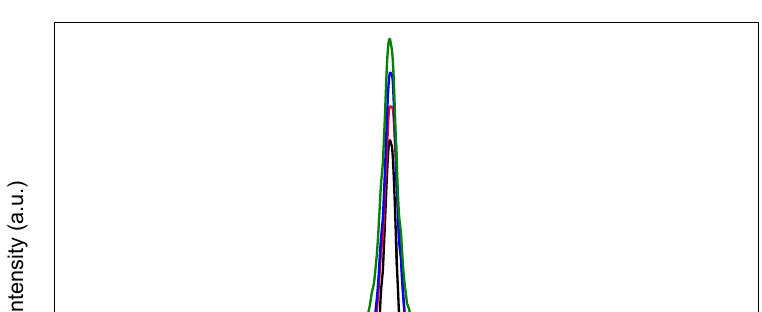
Figure 3. Raman spectra of fresh